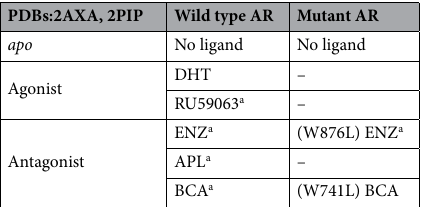
Table 2. Model systems simulated with aMD in this study. a The simulations were performed with the ligands in both conformation 1 and 2.